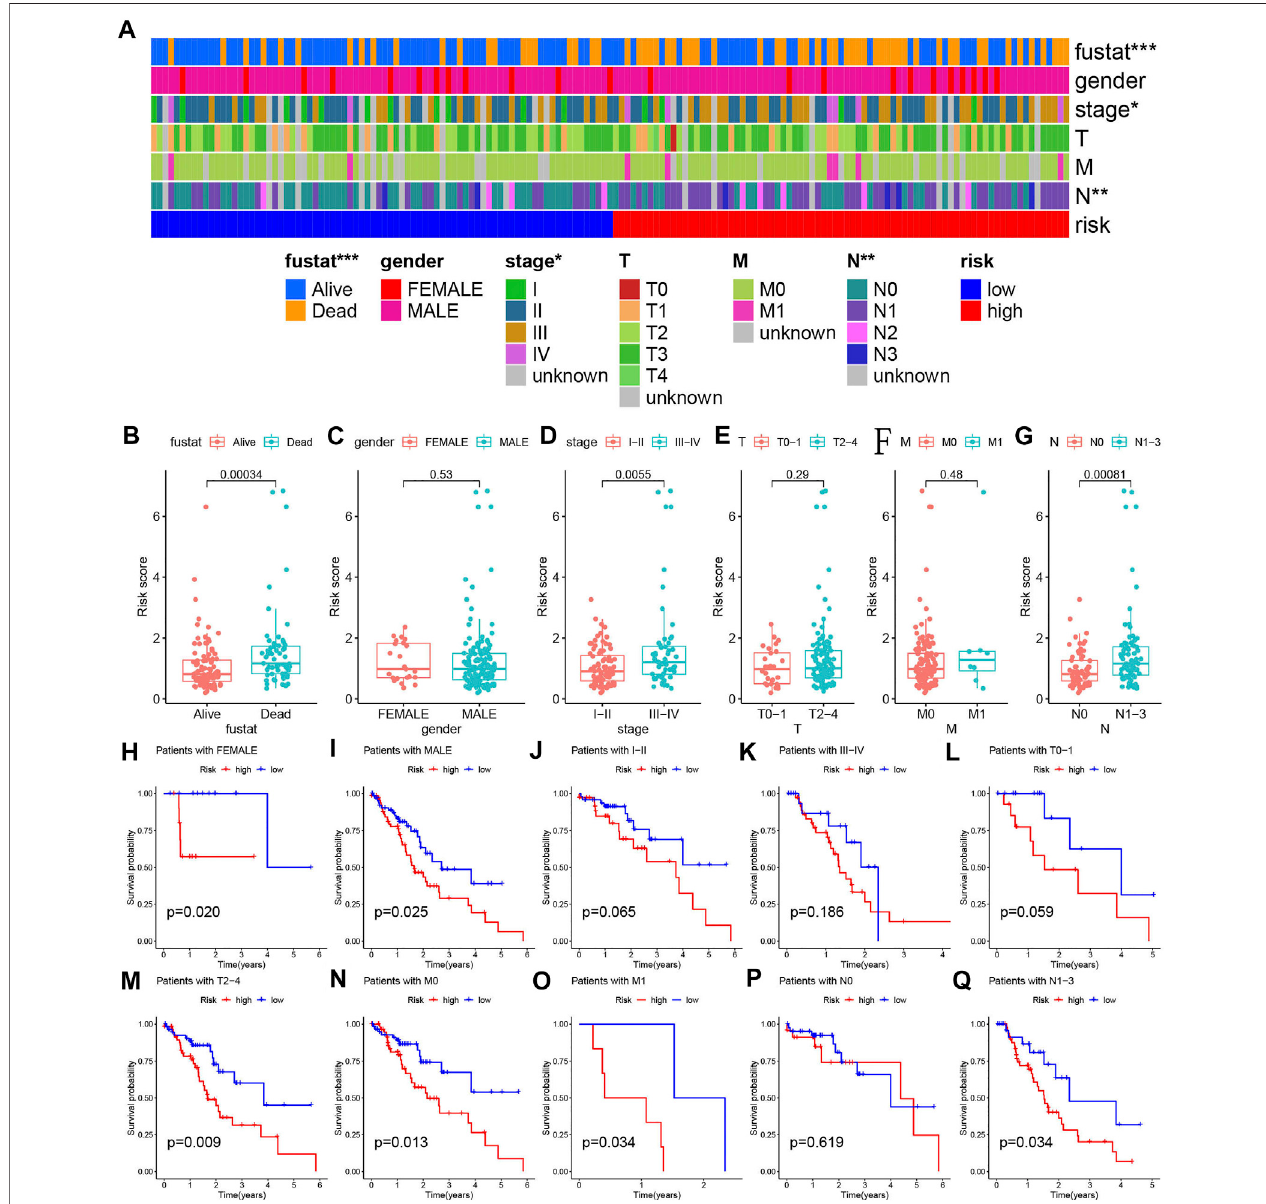
FIGURE5| Detailedanalysesofclinicaldata. (A) Thedistributionofclinicalcharacteristicsandriskforeachdatasample. (B – G) Differencesinriskscoresofpatients with different clinical characteristics. (H – Q) Kaplan-Meier survival plots for different groups by clinical feature.